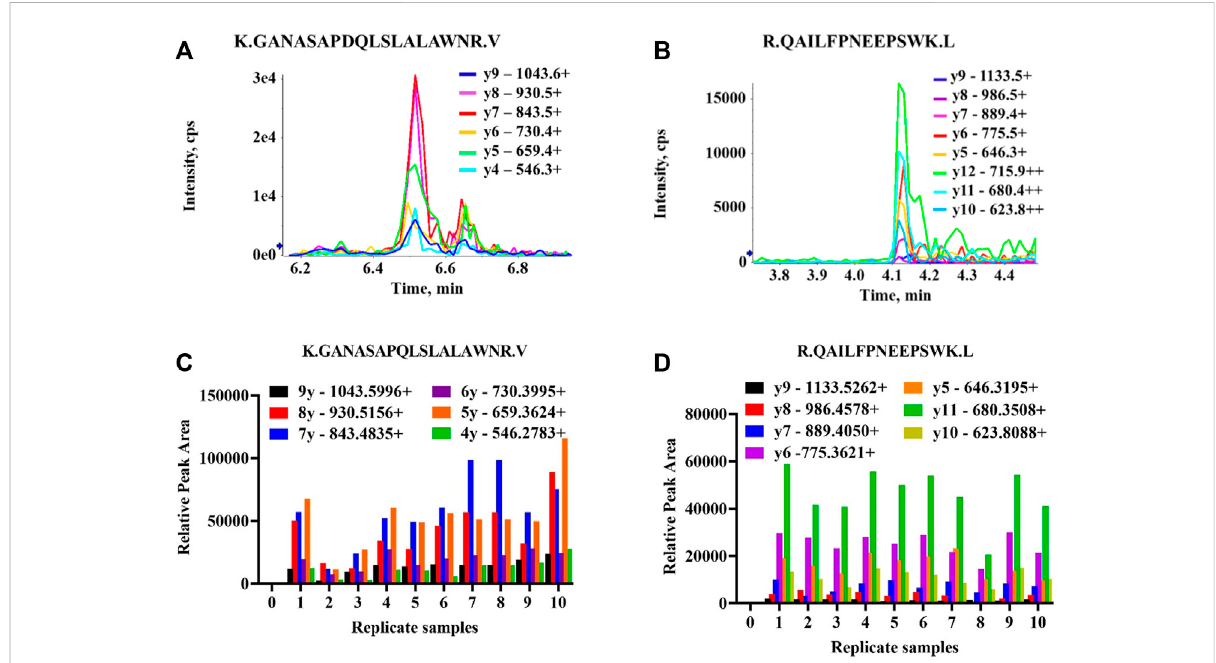
FIGURE 5 Detectability of TRPM3 proteotypic peptide sequences. All transitions (precursor/fragment ion pairs) per peptide were monitored over time yielding a set of chromatographic traces with the retention time and relative signal intensities as coordinates. The resulting MRM peaks were then evaluated for their capability to speci fi cally detect target peptides. (A) MRM traces of six transitions for K.GANASAPDQLSLALAWNR.V peptide. One peak with multiple MRM transitions (parent ion/daughter ions) co-eluting at 6.45 min in one participant protein sample. Each series represents product y ions (ionized amino acids/fragmented peptides) which collectively form target peptide sequences. (B) MRM traces of eight transitions for R.QAILFPNEEPSWK.L peptide. One peak with multiple MRM transitions co-eluting at 4.12 min (C,D) Relative peak areas for multiple MRM transitions co-eluting at the same retention time (6.45 and 4.12 min) detectable across all ten replicate samples (Supplementary Material) for K.GANASAPDQLSLALAWNR.V and R.QAILFPNEEPSWK.L peptides,